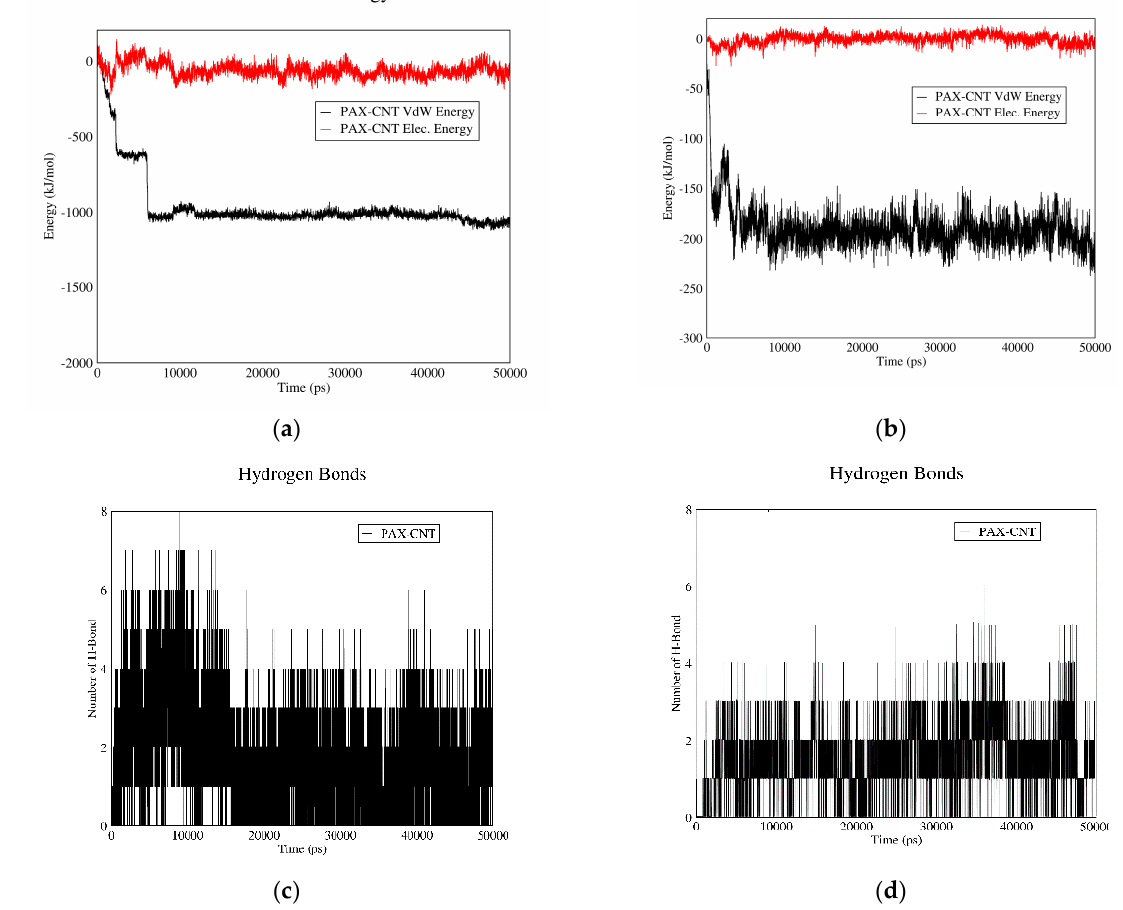
Figure 4. PAX–CNT interaction energies and hydrogen bonds: ( a ) electrostatic and Van der Waals energies of PAX–CNT interaction versus time in neutral pH; ( b ) electrostatic and Van der Waals energies of PAX–CNT interaction versus time in acidic pH; ( c ) the number of hydrogen bonds between PAX and CNT versus time in neutral pH; ( d ) the number of hydrogen bonds between PAX and CNT versus time in acidic pH.